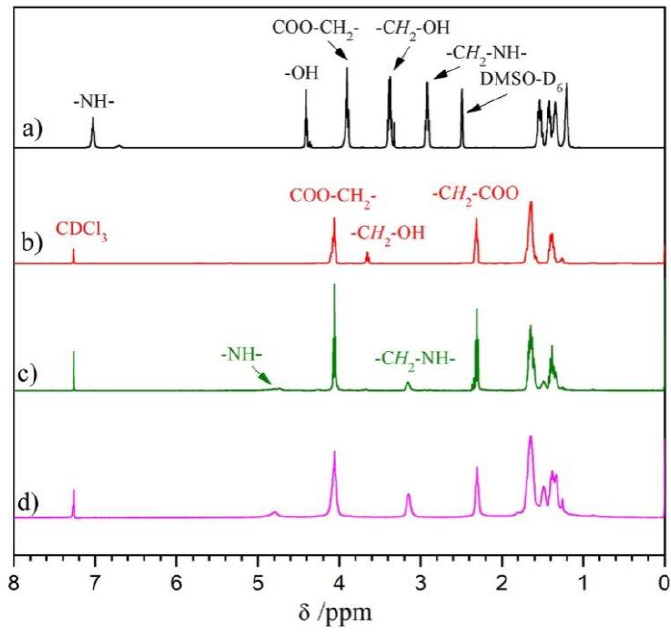
Figure 2. 1 H NMR spectra for ( a ) BHB, ( b ) PCL, ( c ) PEU ‐ 1.0 and ( d ) PEU ‐ 2.0.